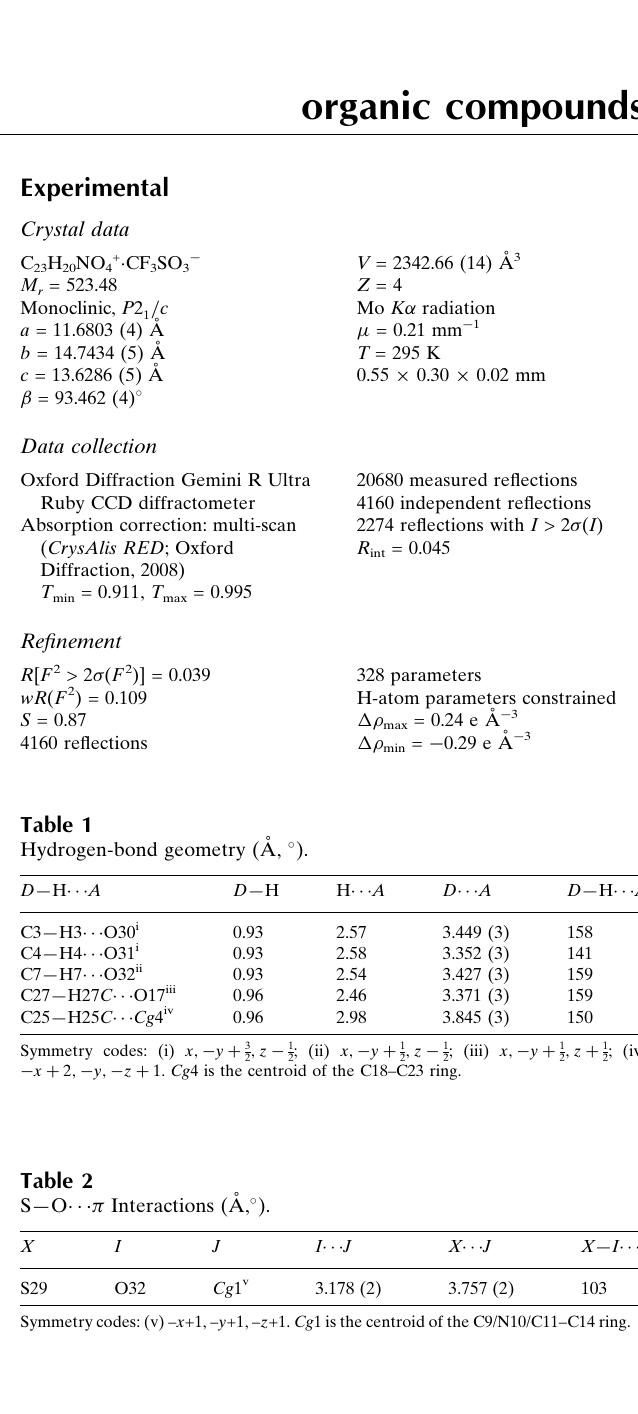
Table 3 (cid:2) – (cid:2) Interactions (A˚ , (cid:3)